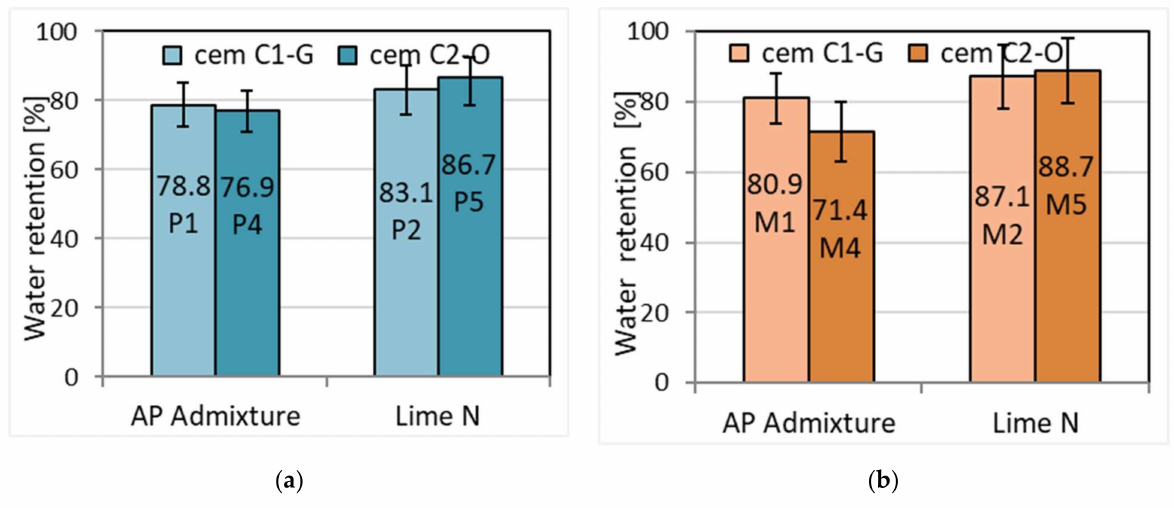
Figure 4. Water retention of ( a ) plaster and ( b ) masonry mortar.